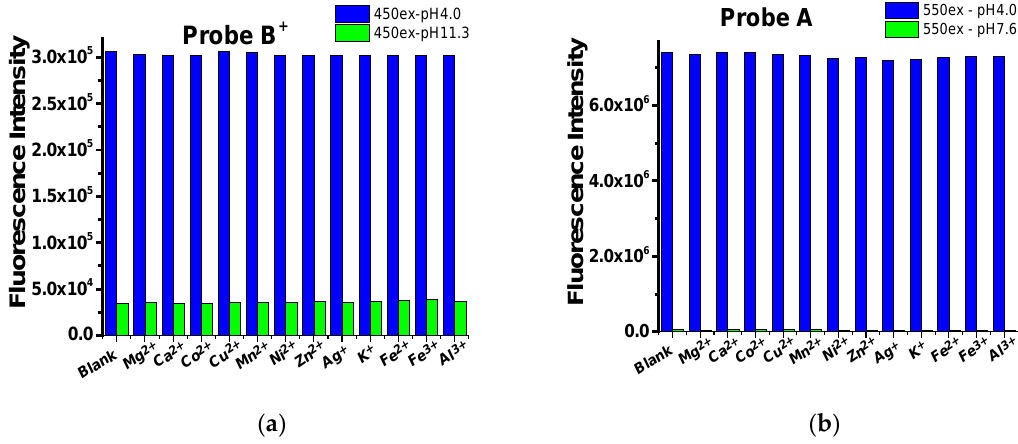
Figure 6. Fluorescence intensity of probes A and B + in the absence and presence of 50 µM different metal ions at pH 4.0 and 11.3 under 450 nm excitation for probe B + ( a ) and under 550 nm excitation for probe A ( b ).